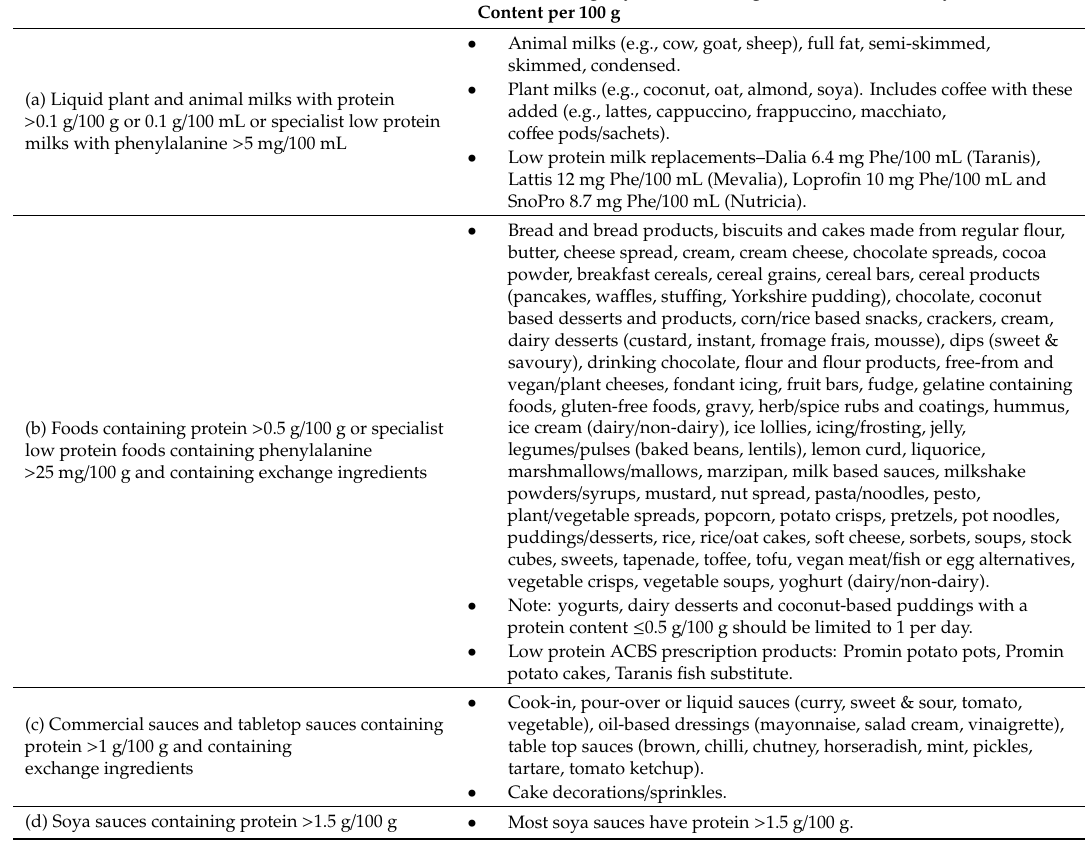
Table 3. Category 3: Manufactured foods allocated as part of an exchange system based on protein or phenylalanine